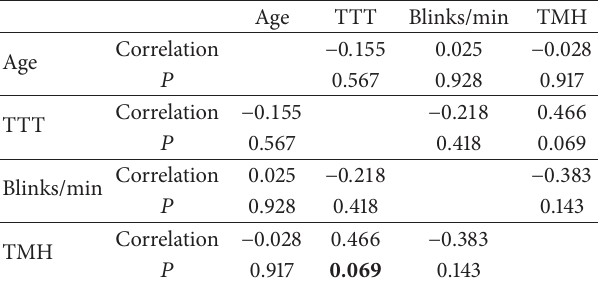
Table 3: The cross relations in Group